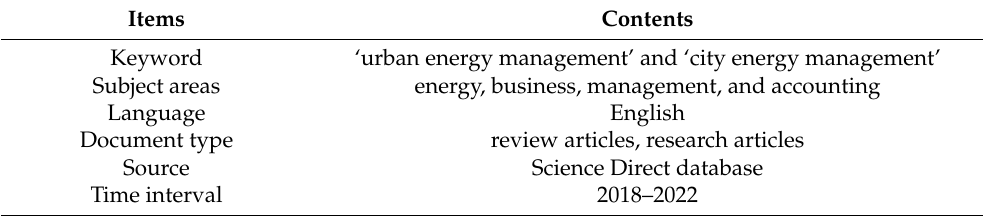
Table 1. Criteria for the analysis of trends in the literature on urban (city) energy